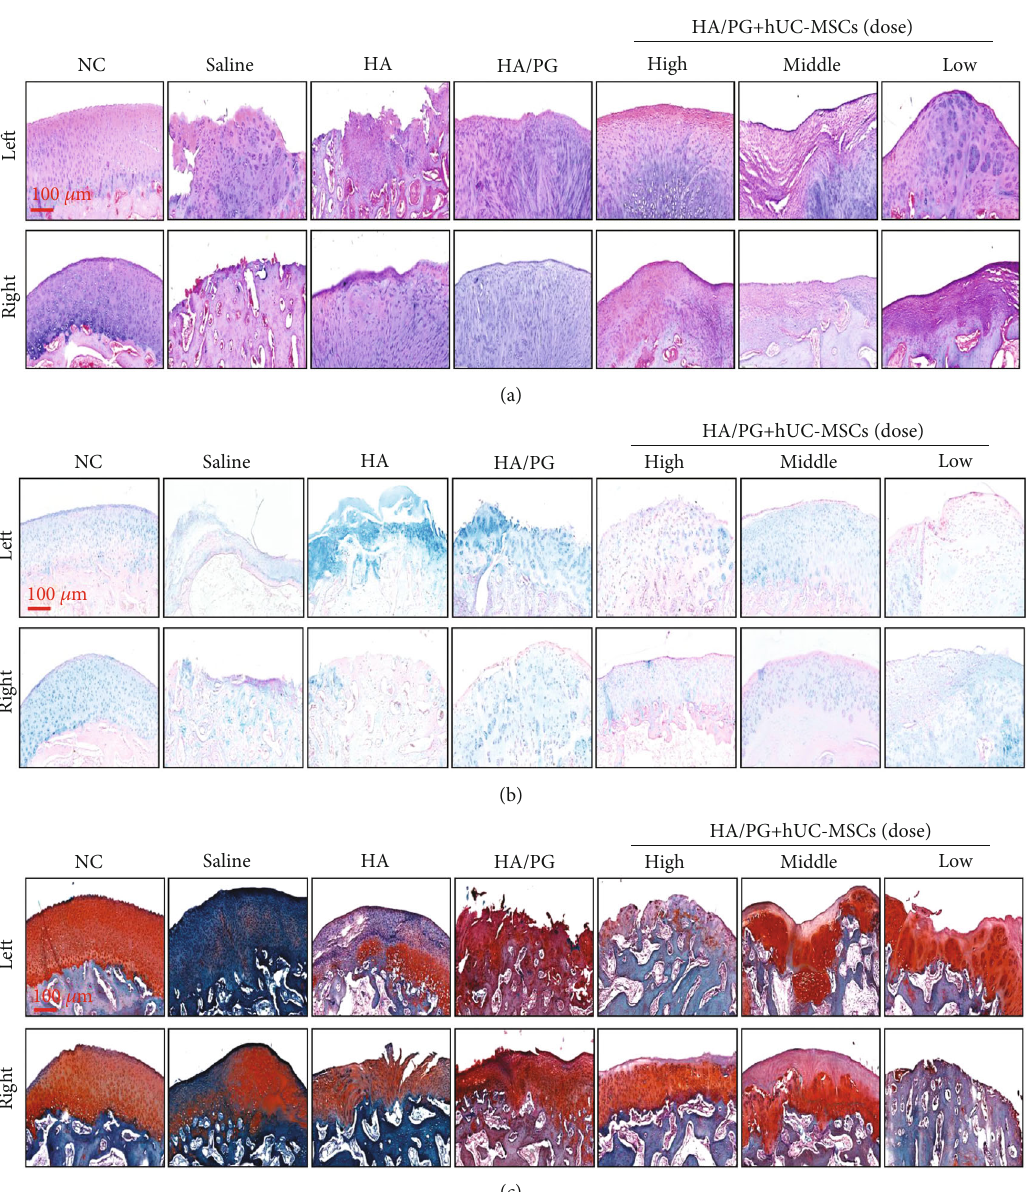
Figure 2: Clinicopathological assessment of the osteochondral defects in rabbits with UC-MSC and/or HA/PG composite administration. (a – c) Representative histological images of the articular cartilage in the indicated groups with H&E staining (a), Alcian blue staining (b), and Safranin-O/fast green staining (c), respectively. Scale bar = 100 μ m. The surface changes and loss of collagen and proteoglycans were shown by the